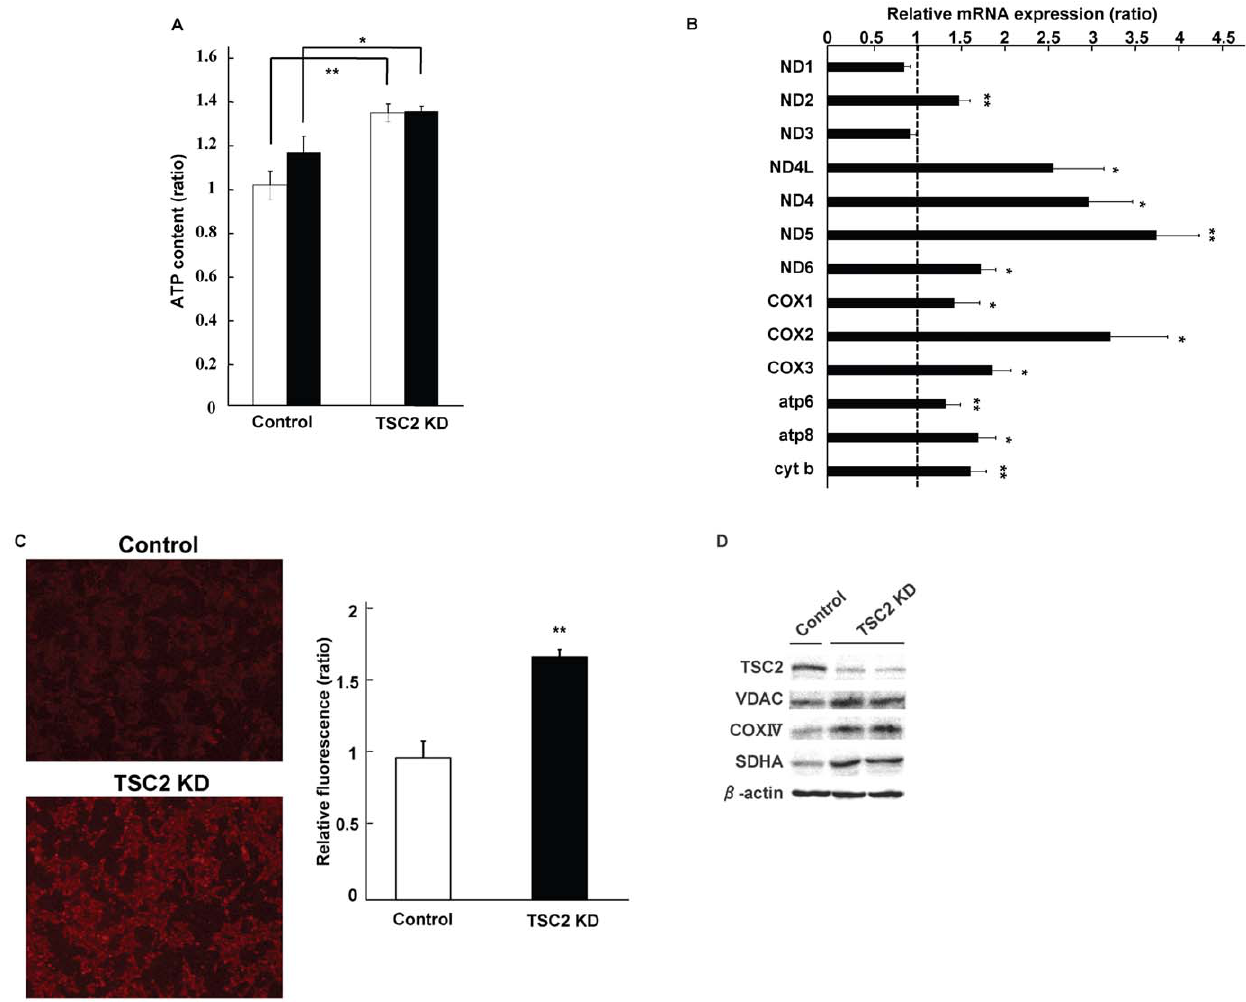
Figure 4. Effect of TSC2 knockdown on the function of mitochondria from INS-1 cells. ( A ) ATP content of control and TSC2. Cellular ATP level was measured at 2.8 mM (white bar) and 25 mM (black bar) glucose ( n =12). The figure shows data from one representative of four independent experiments. ( B ) The level of mRNA expression of mitochondria DNA-encoded genes obtained by real-time PCR. Data are means 6 SE of triplicate for pooled total RNA samples from three independent experiments. The amounts of the mRNAs in TSC2 INS-1 cells are expressed relative to those in control cells. ( C ) Mitochondrial density measured as described in the Material and Methods with MitoTracker Red. Left panel: Mitochondria in control cells and TSC2 INS-1 cells were stained. Right panel: Relative fluorescence was measured by fluorescence-activated cell sorting analysis after MitoTracker Red staining. Data were obtained from three independent experiments. ( D ) Mitochondrial protein expression assessed by western blotting in INS-1